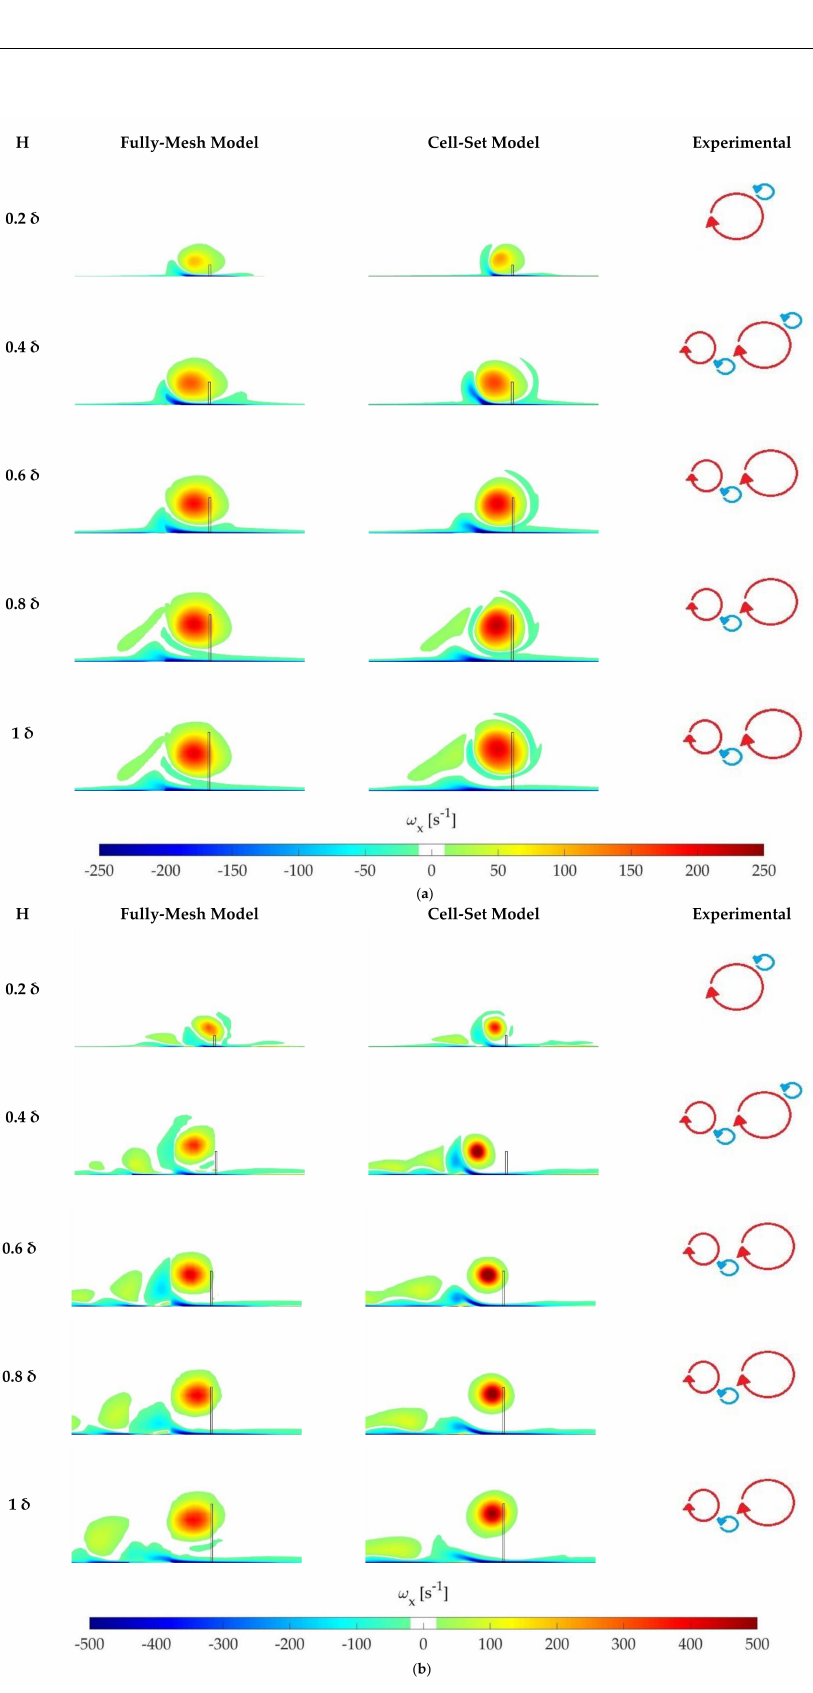
Figure 8. Vortical structures predicted on the wake behind the VG. ( a ) Reynolds-Averaged Navier- Stokes (RANS) ( α = 18 ◦ ) and ( b ) Large Eddy Simulation (LES) ( α = 25 ◦